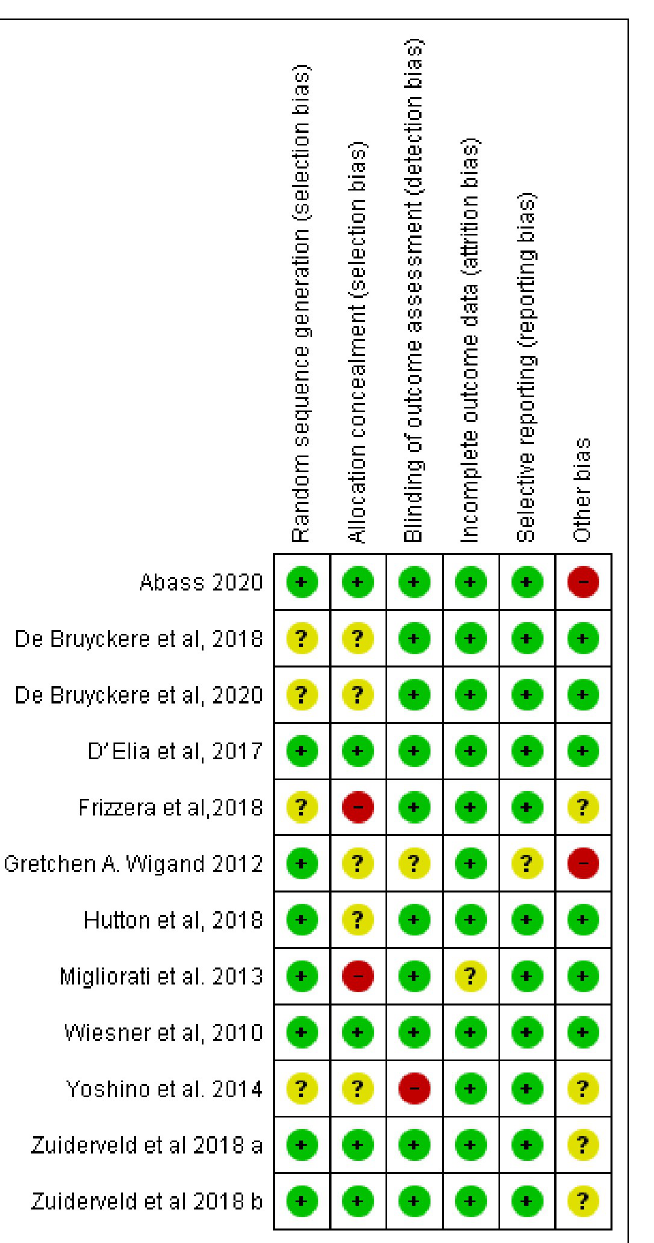
Fig 2. Result of risk of bias assessment of the included